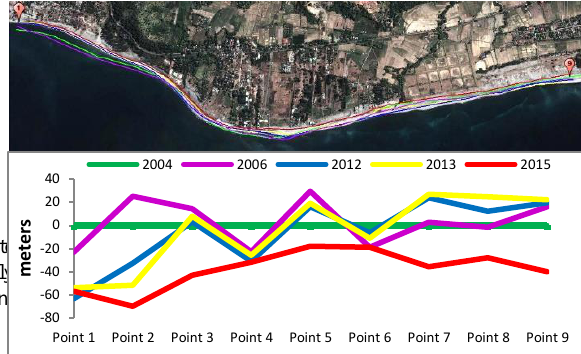
Figure 5. South Coast of Bucao